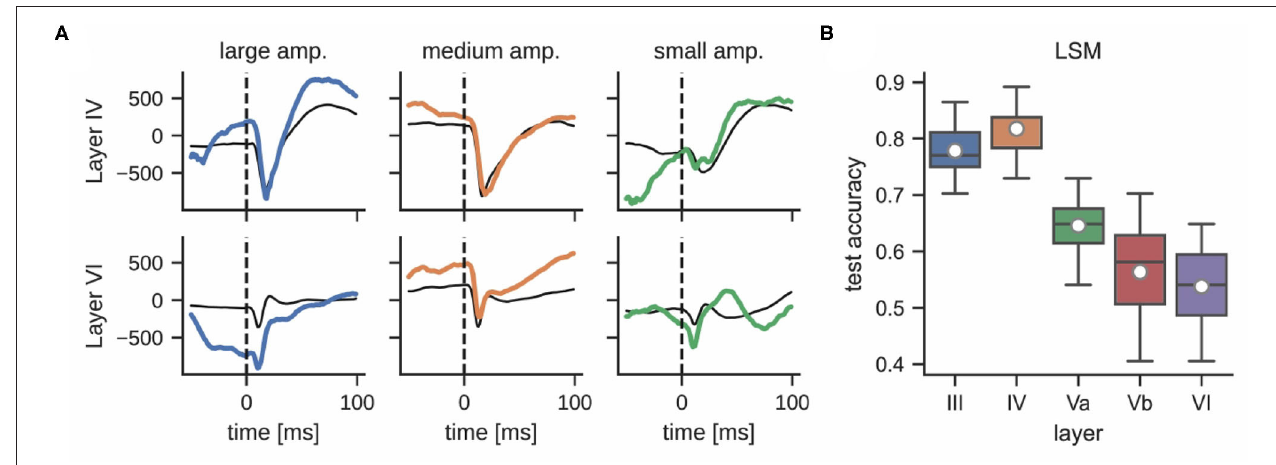
FIGURE 6 | (A) LFPs in layer IV (top) and layer VI (bottom) after delivering a single stimulus for each whisker deflection amplitude (same color corresponds to same stimulation trial, units in µ V ). The response of these layers to the same stimulation differs significantly; the thin black line shows the mean signal per layer and stimulation intensity. (B) Classification accuracy of a liquid state machine grouped by